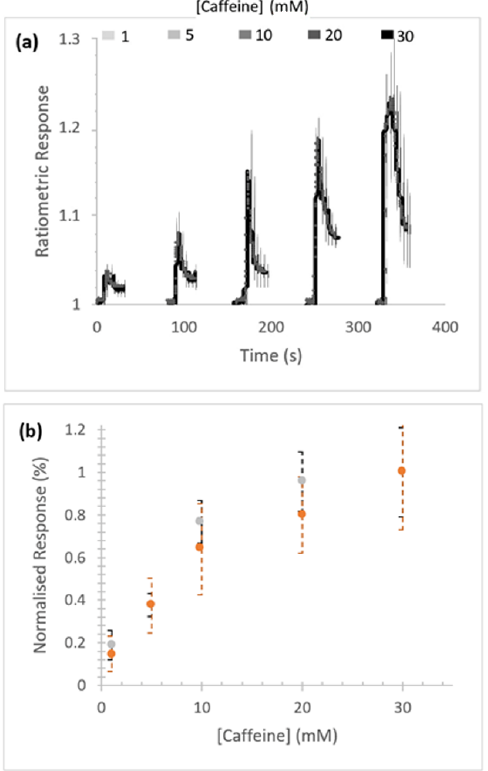
Figure 3. Response of RFCLM-PxRyR to increasing concentrations of caffeine. ( a ) Averaged response of cells in a given field of view. Data is presented as mean (solid line) and standard error of the mean (SEM). ( b ) Proportional normalised responses (see Methods) of those same RFCLM-expressing cells (orange) compared alongside WT-expressing cells (grey). Error bars are standard error of mean (SEM).